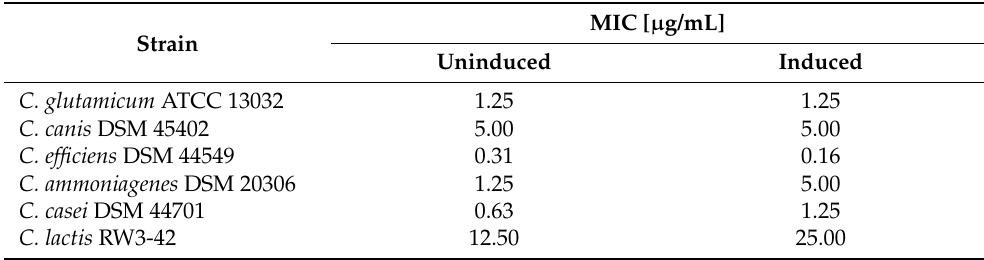
Figure 6. Radial streak assays of six different Corynebacterium species on 2xTY agar. ( A ) 50 µL of a nisin solution (0.25 mg/mL) were spotted in the middle of 2xTY agar plates. Overnight cultures of the indicated strains were streaked over a length of 3.5 cm from the black dot in the upper left corner of the image towards the center of the nisin spot. The plates were incubated for 4 days. The broken black lines indicate the boundary of growth after 24 h. ( B ) Measurements of the radius of the zone of growth inhibition from the center of the nisin spot at the indicated time after inoculation. One representative of two experiments is shown for each strain. Table 3. Minimal inhibitory concentrations (MIC) of various Corynebacterium species strains deter- mined in the experiments shown in Figure S8 with (induced) or without (uninduced) preincubation in medium containing sublethal concentrations of